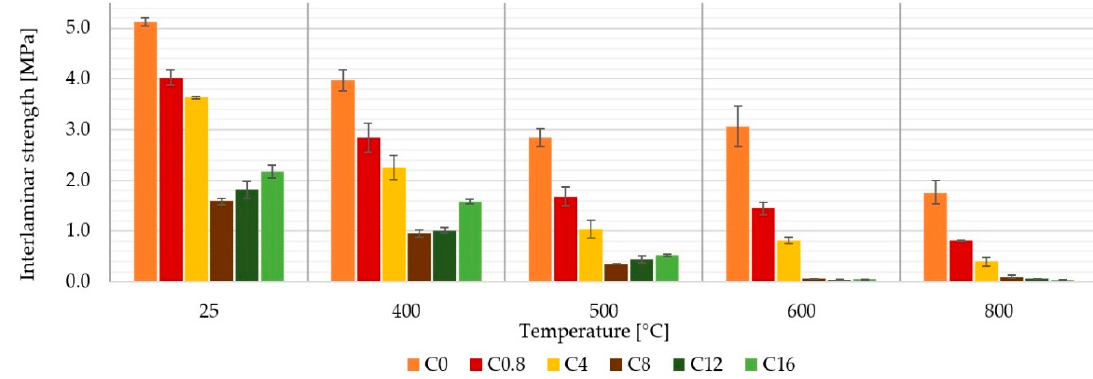
Figure 7. Influence of boron content in the matrix on the interlaminar strength of composites.